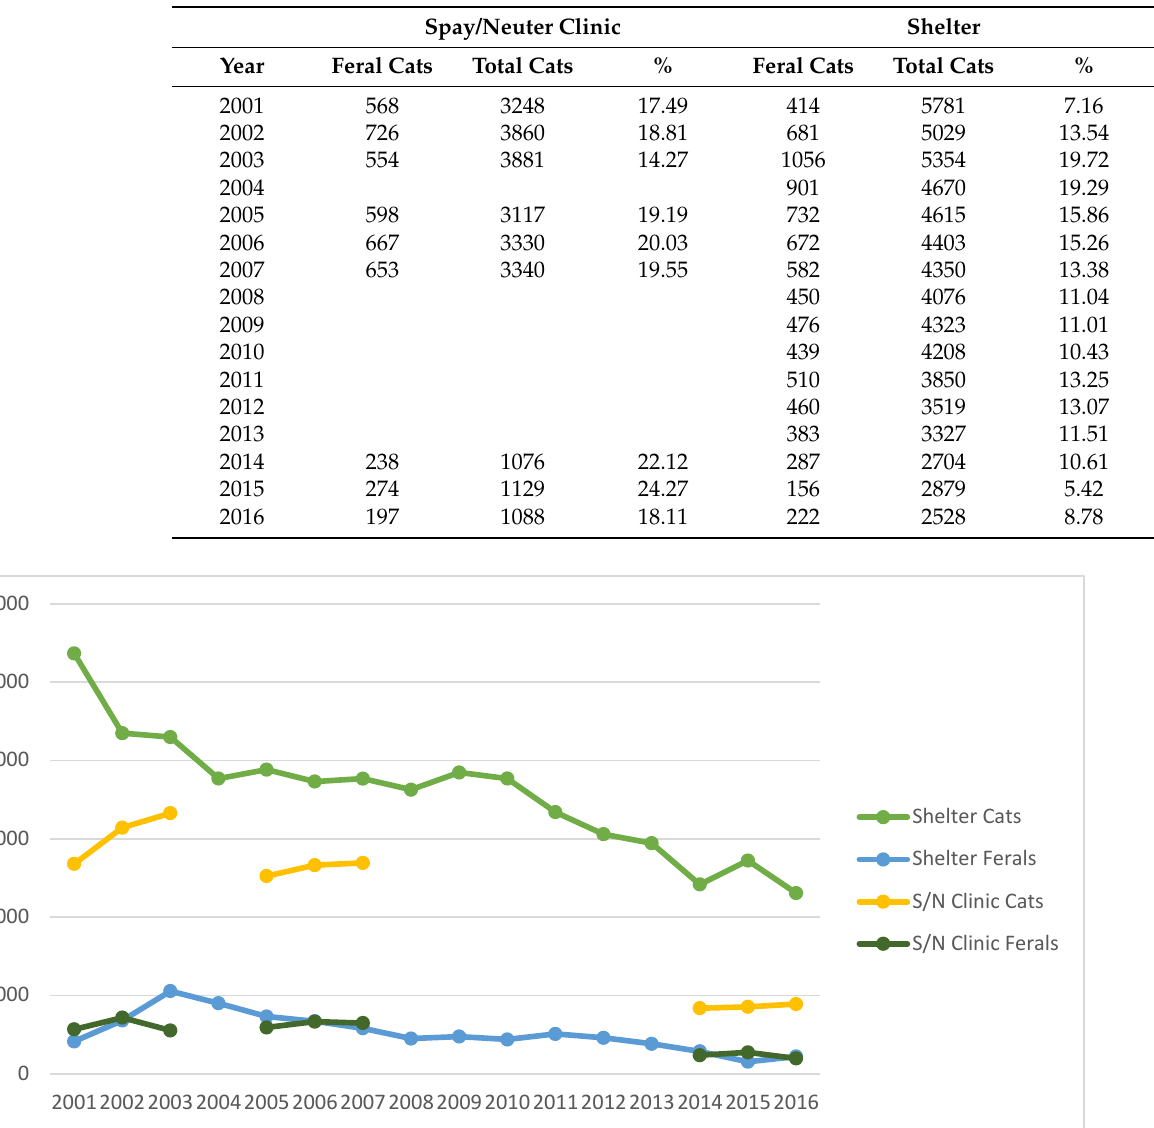
Table 1. Numbers and proportions of feral cats admitted to the PHS Shelter and the Spay/Neuter Clinic, 2001–2016.